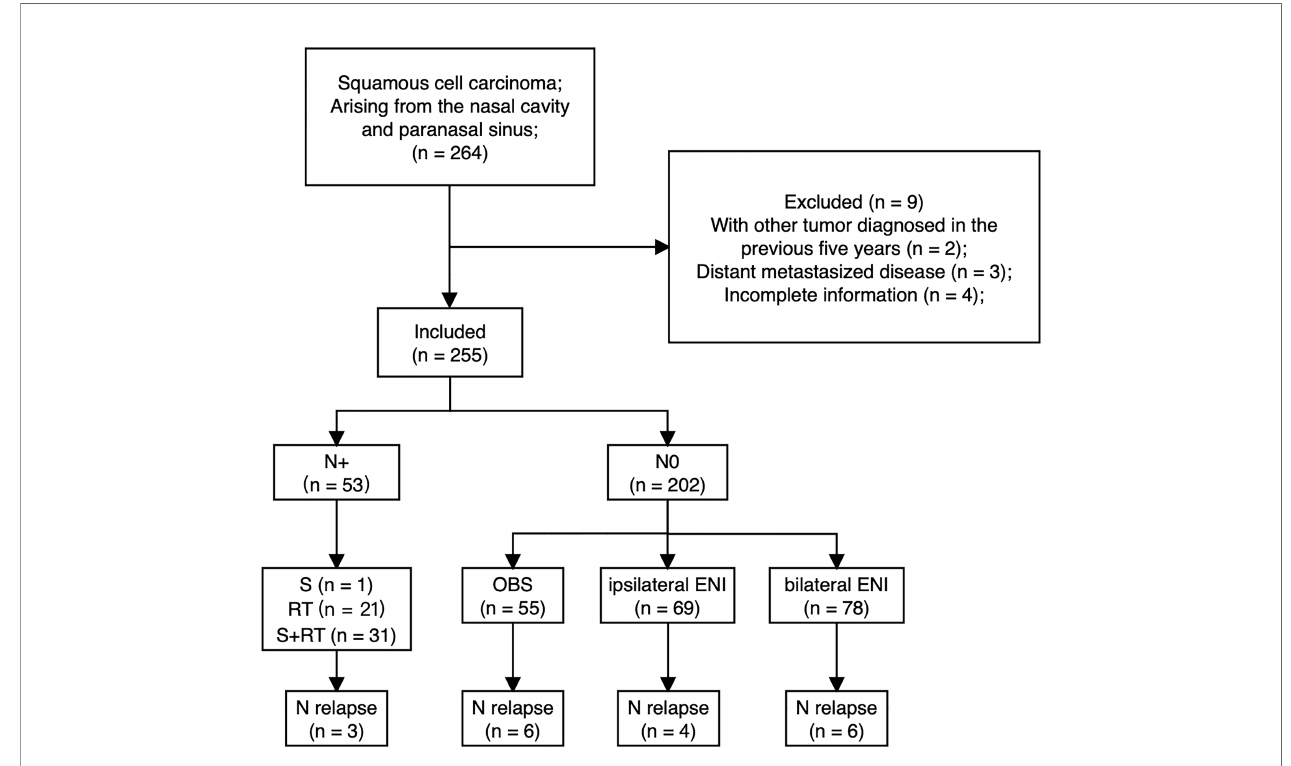
FIGURE 1 | Patient selection and treatment fl ow